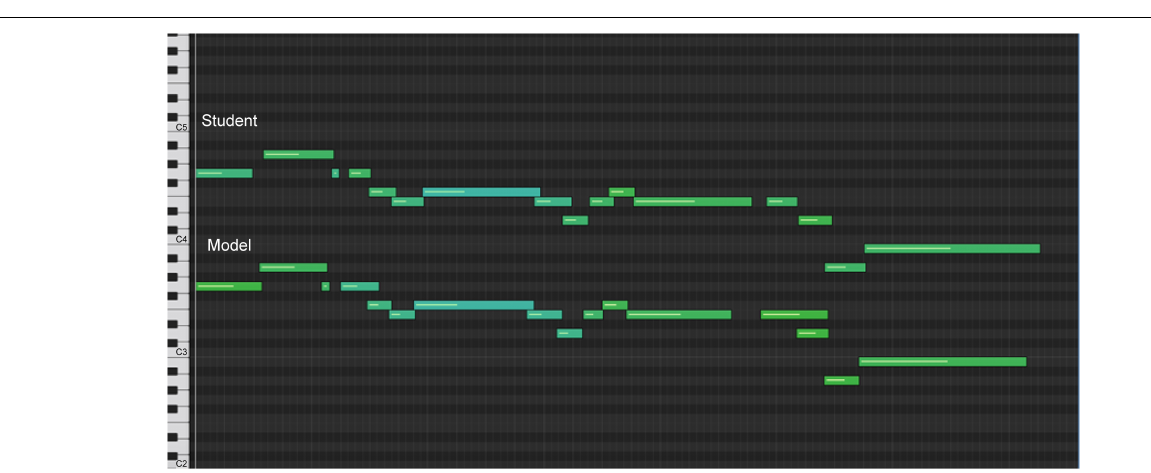
FIGURE 8 | Measure 5 to downbeat of measure 8 from piano score.